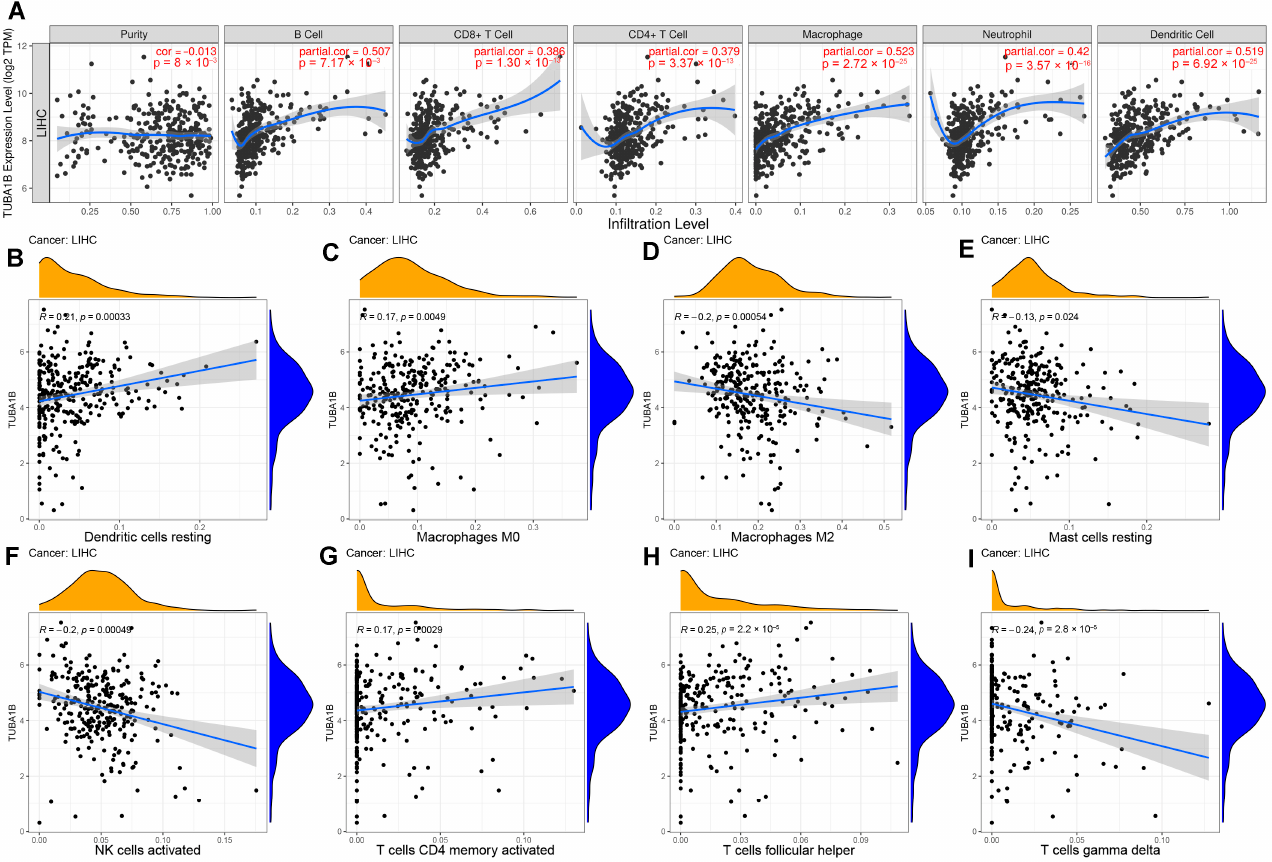
Figure 4. TUBA1B expression was in relation to immune cell infiltration in LIHC. ( A ) The relationship of TUBA1B expression with tumor purity and the infiltration of major immune cells including CD4+ T cells, B cells, CD8+ T cells, macrophage, dendritic cell, and neutrophil from TIMER. The relationship of TUBA1B expression with resting dendritic cells ( B ), macrophages M0 ( C ), macrophages M2 ( D ), resting mast cells ( E ), activated NK cells ( F ), activated memory CD4 T cells ( G ), T cells follicular helper ( H ), and T cells gamma delta ( I ) explored using the CIBERSORT algorithm.